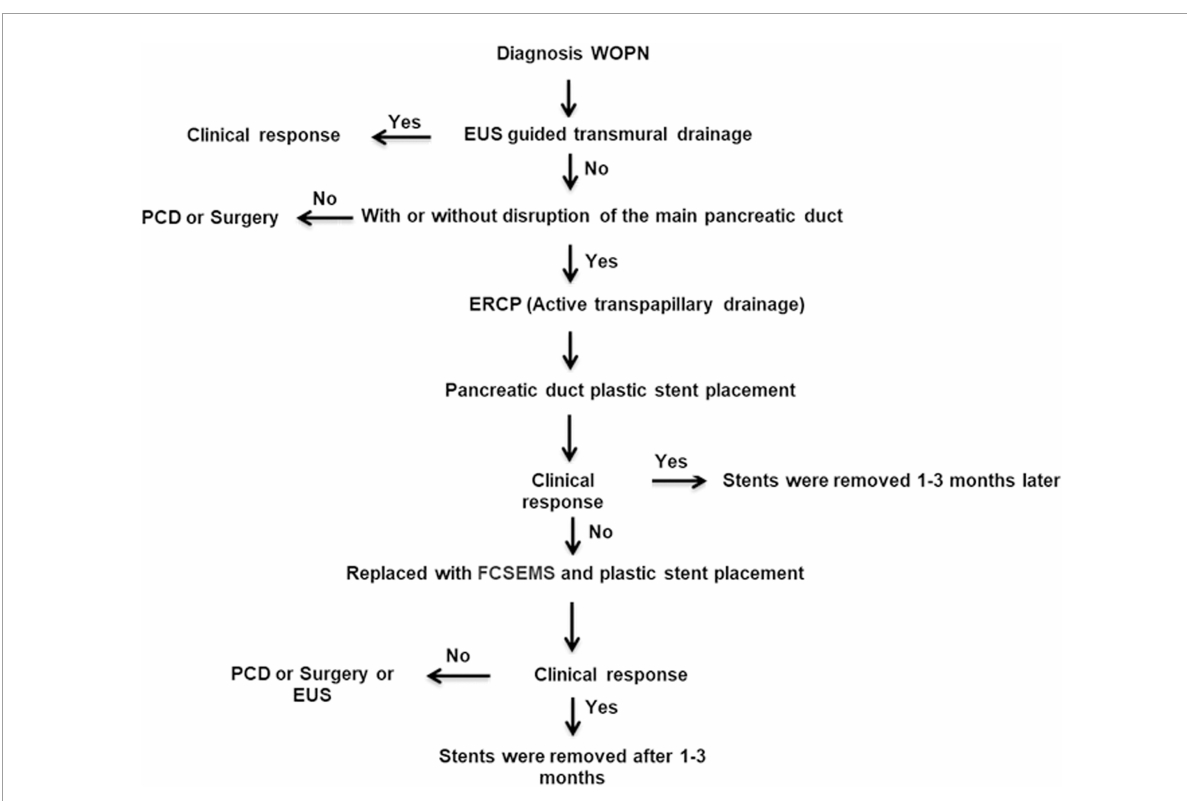
FIGURE1 Algorithmic approach to the management of walled-off pancreatic necrosis with complete main pancreatic duct disruption by endoscopic transpapillary drainage with fully covered self-expanding metallic stent and plastic stent placement in our center. WOPN, walled-off pancreatic necrosis; EUS, endoscopic ultrasound; PCD, percutaneous catheter drainage; ERCP, endoscopic retrograde cholangiopancreatography; FCSEMS, fully covered self-expanding metallic